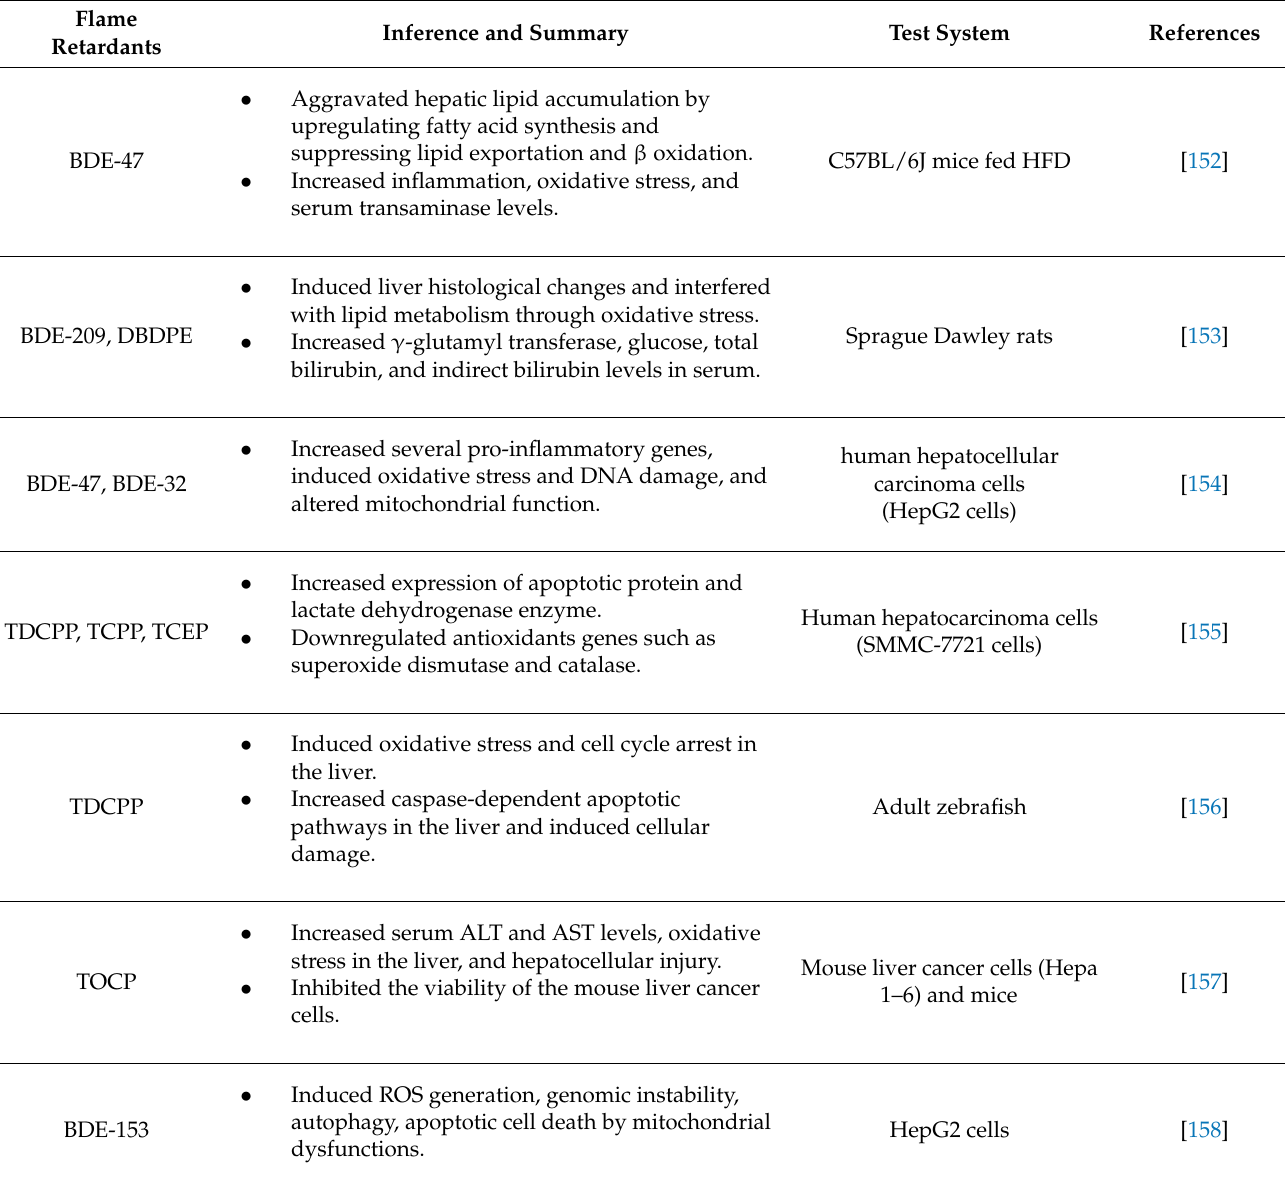
Table 1. In vitro and in vivo experimental evidence highlighting the hepatotoxic potential of FRs and associated biochemical dysregulations. Flame